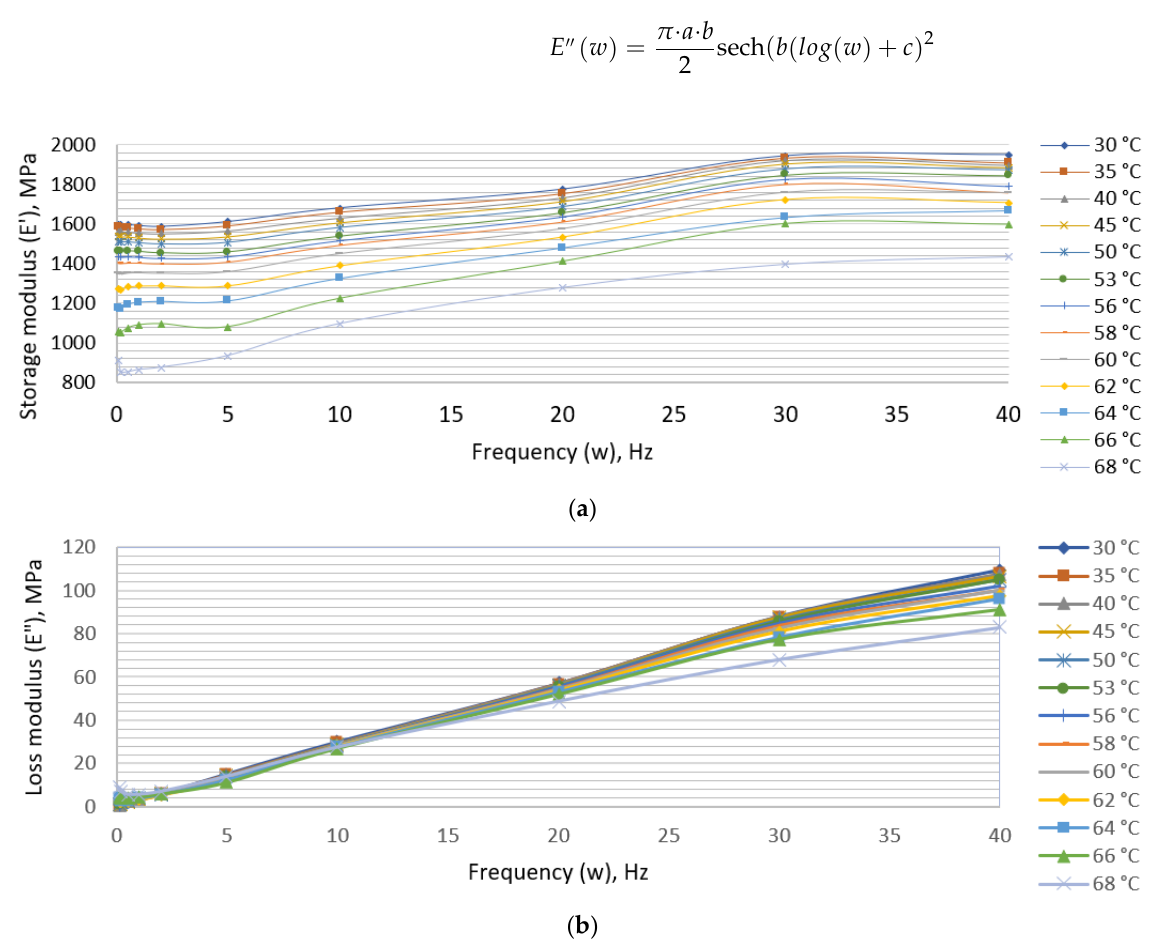
Figure 2. Experimental values: ( a ) Storage modulus; ( b ) Loss modulus.